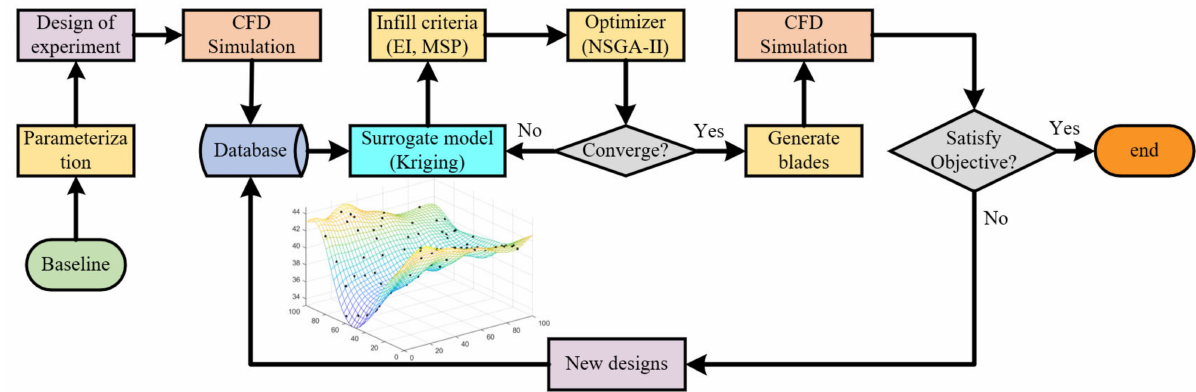
Figure 7. Aerodynamic optimization flow